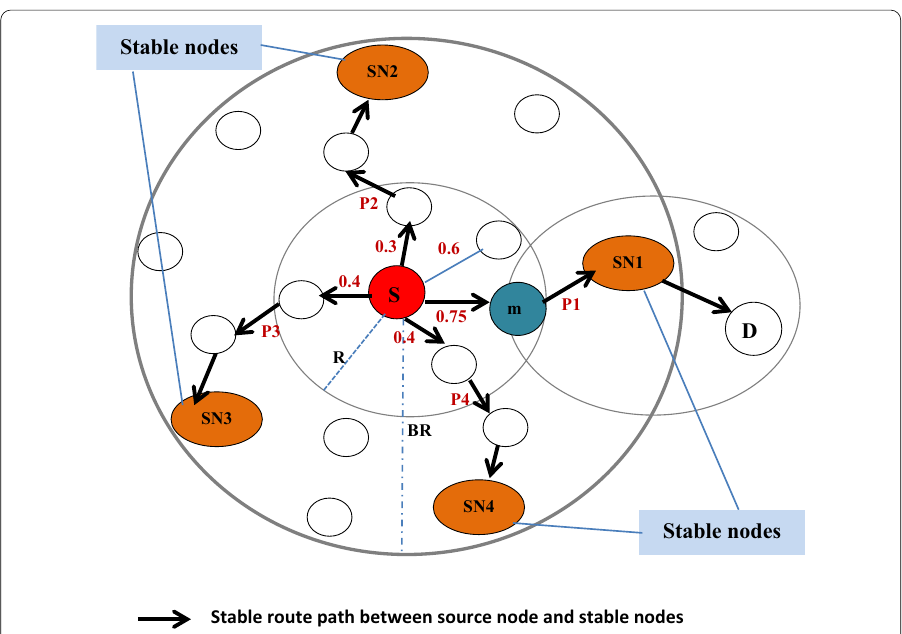
Fig. 2 Stable node path